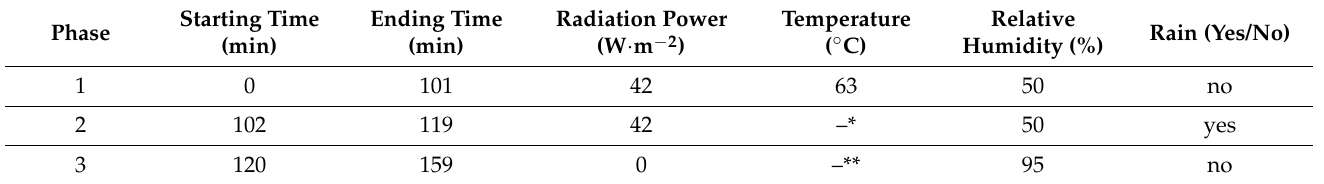
Table 1. Routine of chamber conditioning to simulate working environment. Rain: 500 mL/min of distilled water delivered on the top of the samples. *: temperature controlled by the rain (distilled water at room temperature). **: no constant temperature due to no radiation or heating